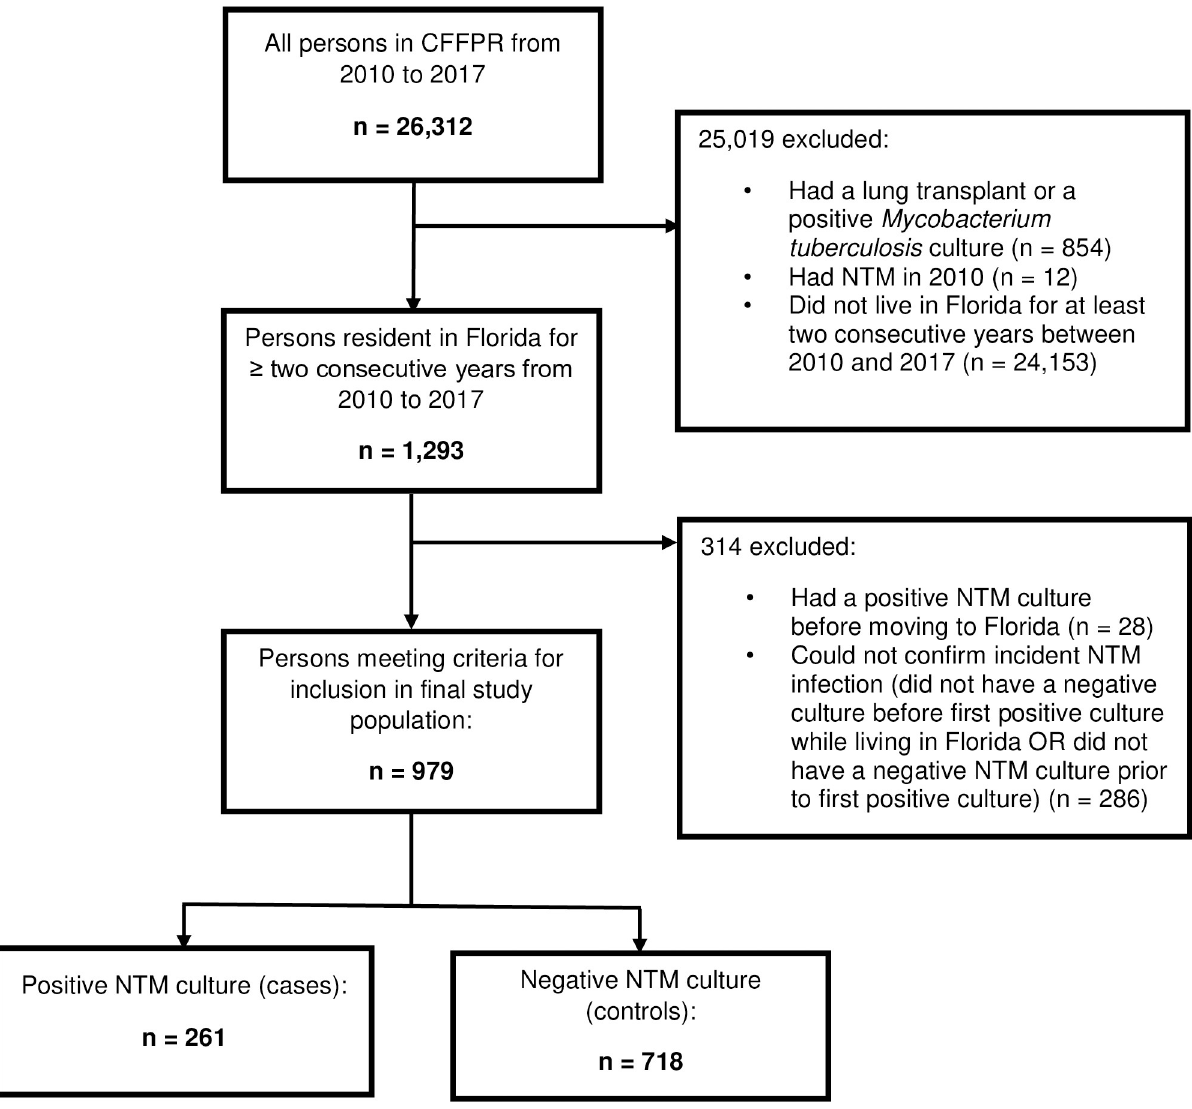
Fig 1. Study population for incident NTM cases and negative controls in the CFFPR from 2010 through